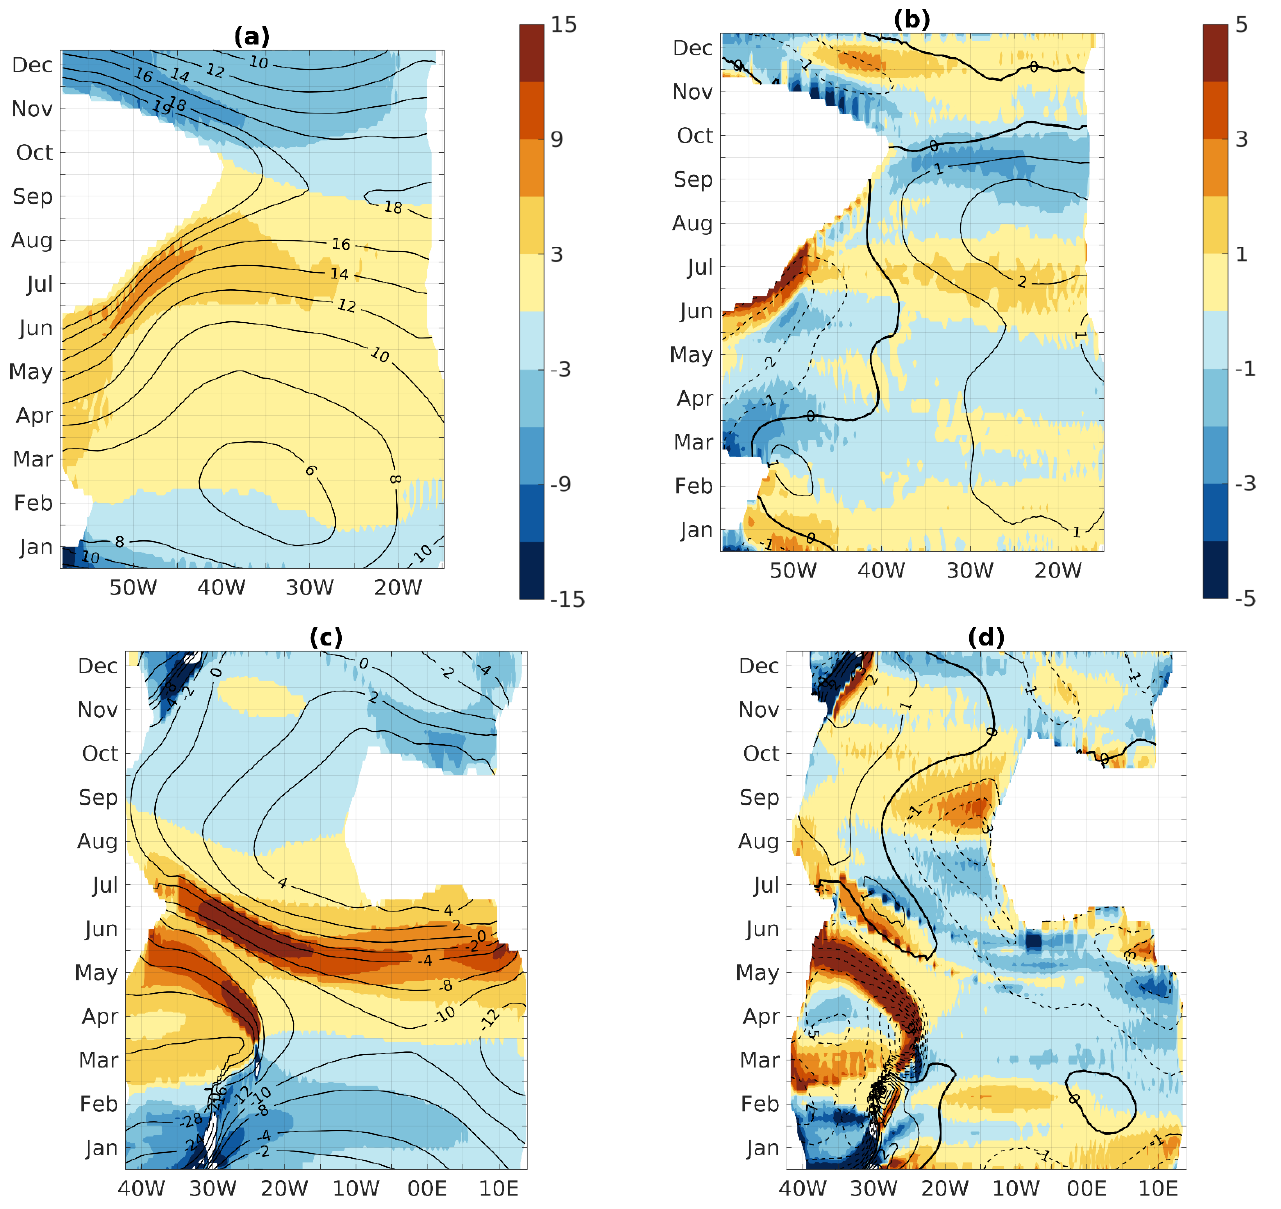
Figure 3. Migration velocities (°lat/month, color) and meridional position (°lat, contour) of NB ( a ) and SB ( c ). Absolute bias, compared to observational datasets SST Reynolds, in migration speed (°lat/month, color) and meridional position (°lat, contour) for NB ( b ) and SB ( d ). Regarding the bias, negative (positive) values of position bias are shown in continuous (dashed) contours. For a better representation, we have chosen not to show latitudes above 19° N for the NB.